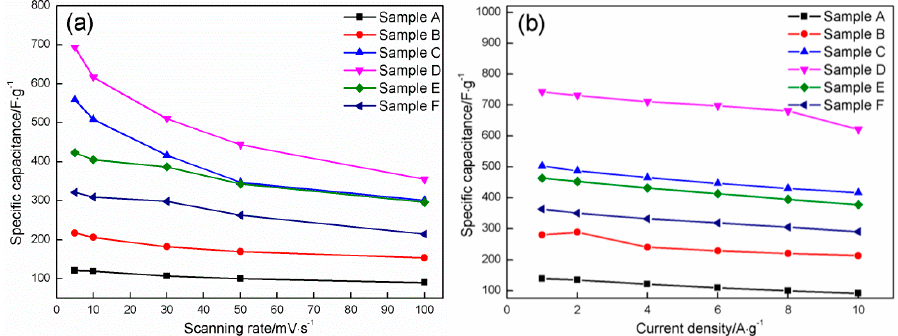
Figure 13. ( a ) Specific capacitance of six samples as a function of scanning rate; ( b ) Specific capacitance of six samples as a function of current density.